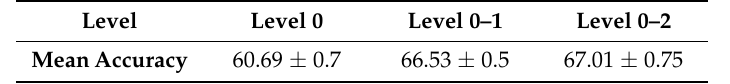
Table 3. Test accuracy mean ± std% over different spatial